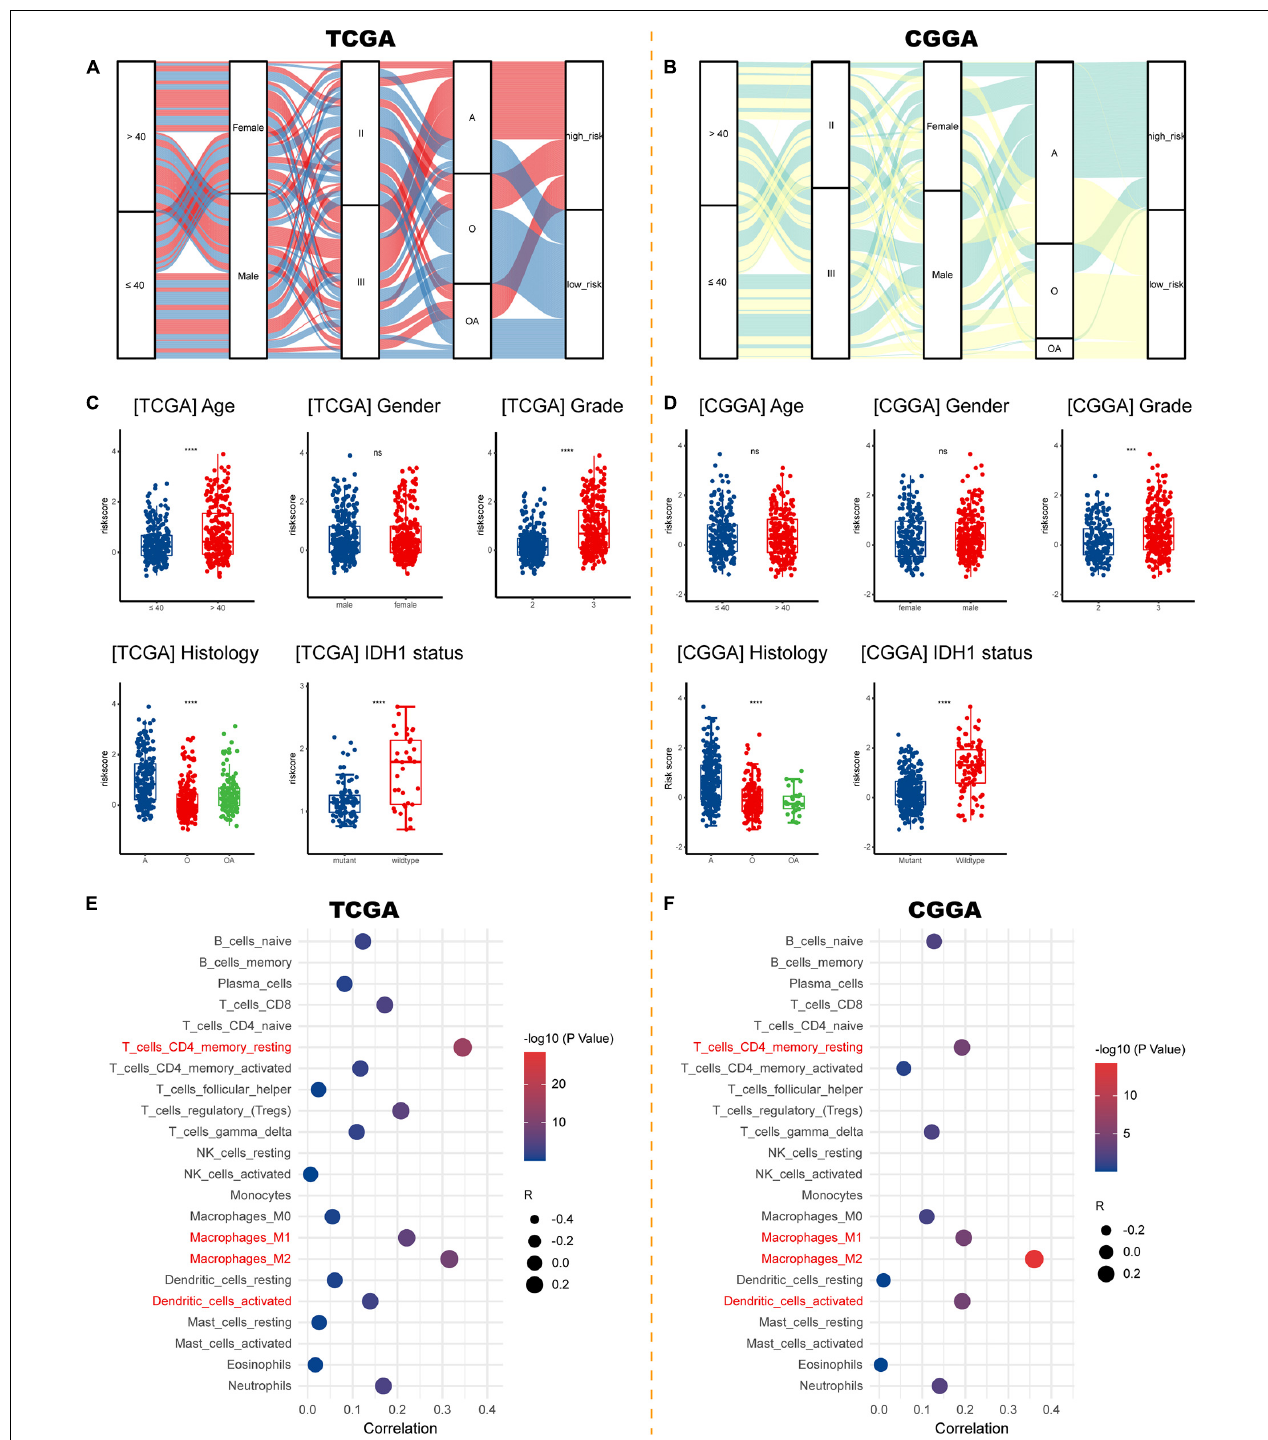
FIGURE 7 | Correlations between risk signature and clinicopathological characteristics. (A,B) Sankey diagrams showing the distribution of risk score and clinicopathologic characteristics in the TCGA and CGGA cohorts. (C,D) The risk score in different subgroups stratified by age, gender, WHO grade, histological type, and IDH1 status in the TCGA and CGGA cohorts. (E,F) Correlations between risk score and immune infiltration in the TCGA and CGGA cohorts. *** p < 0.001, **** p < 0.0001, ns, not significant. A, astrocytoma; O, oligodendroglioma; OA, oligoastrocytoma; IDH1, isocitrate dehydrogenase 1.